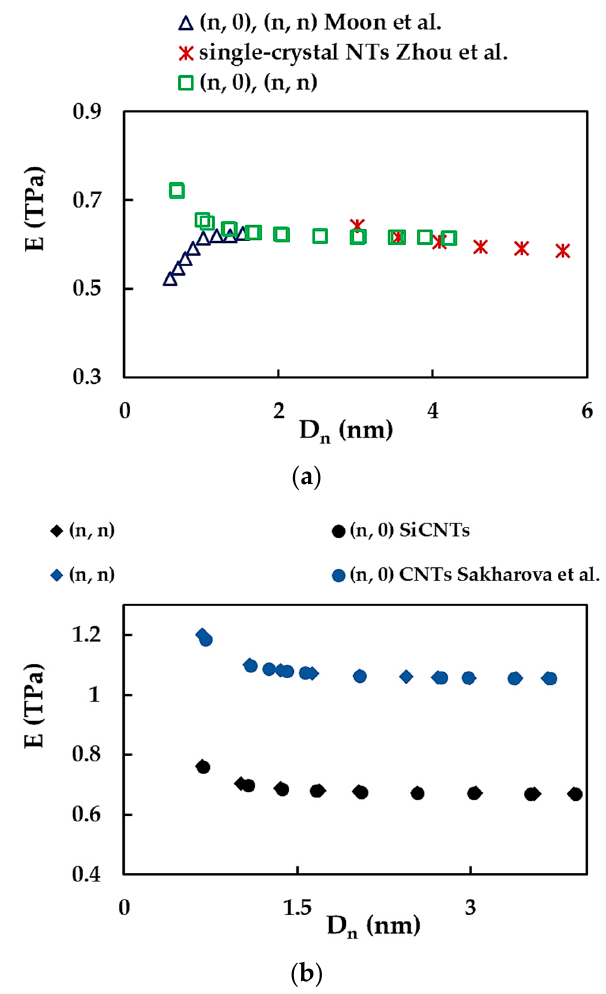
Figure 7. ( a ) Comparison of the current Young’s modulus, E, results calculated for the wall-thickness t n = 0.37 nm with those by Moon et al. [13] and Zhou et al. [16]; ( b ) comparison of the E values of SWSiCNTs with those of SWCNTs [25], for t n = 0.34 nm in both cases.